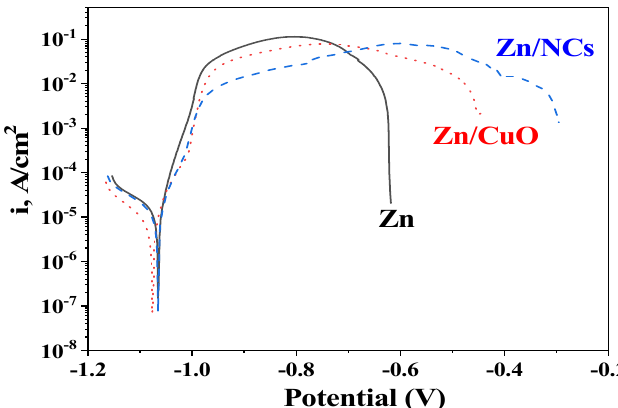
Figure 7. Potentiodynamic polarization measurements in 5% NaCl solution. Table 2. Electrochemical parameters obtained from the potentiodynamic polarization